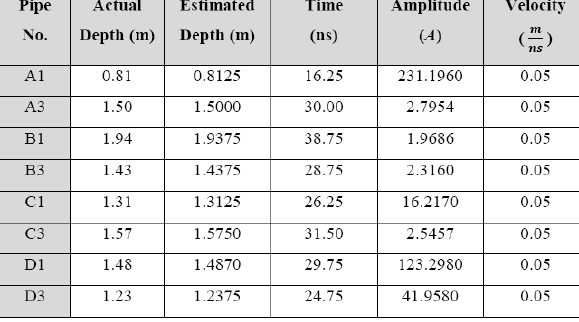
Table 4 . Details obtained from the estimated pipes’ location